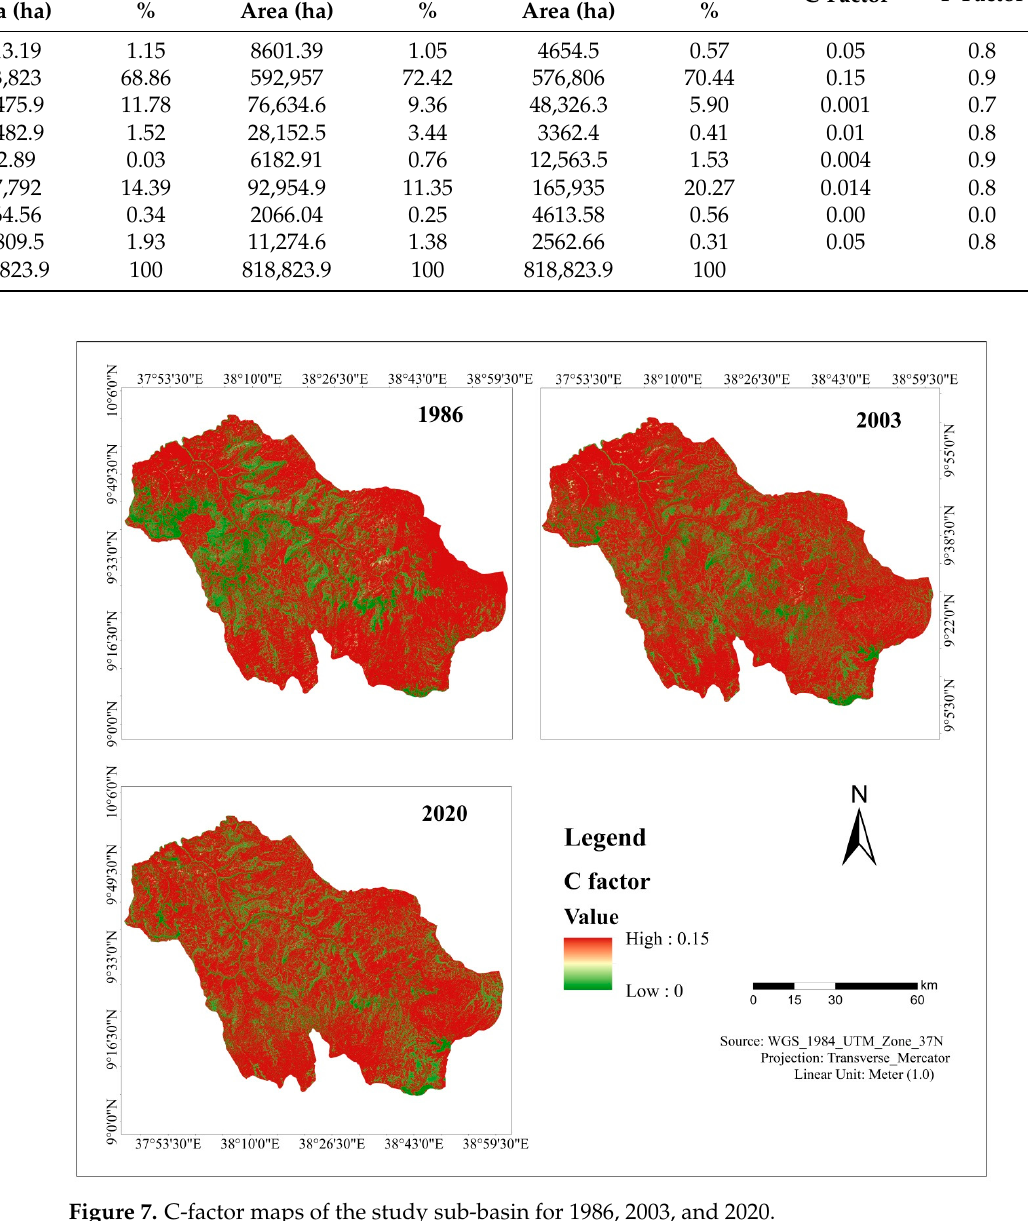
Figure 7. C-factor maps of the study sub-basin for 1986, 2003, and 2020.